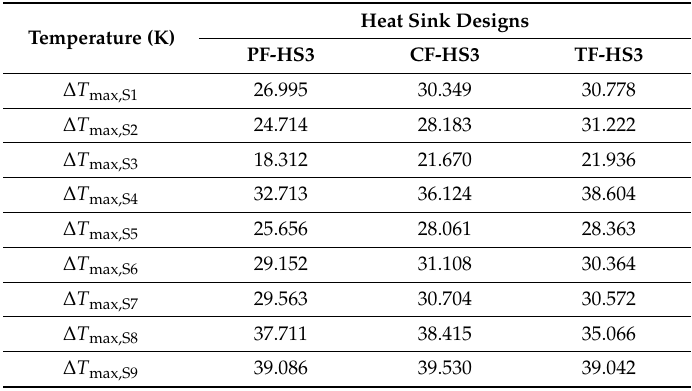
Table 10. Total thermal resistances and maximum temperature increases at the hotspots of the PF, CF, and TF heat sinks for the hotspot scheme HS3 at the total flow rate of 0.01 kg/s. Temperature